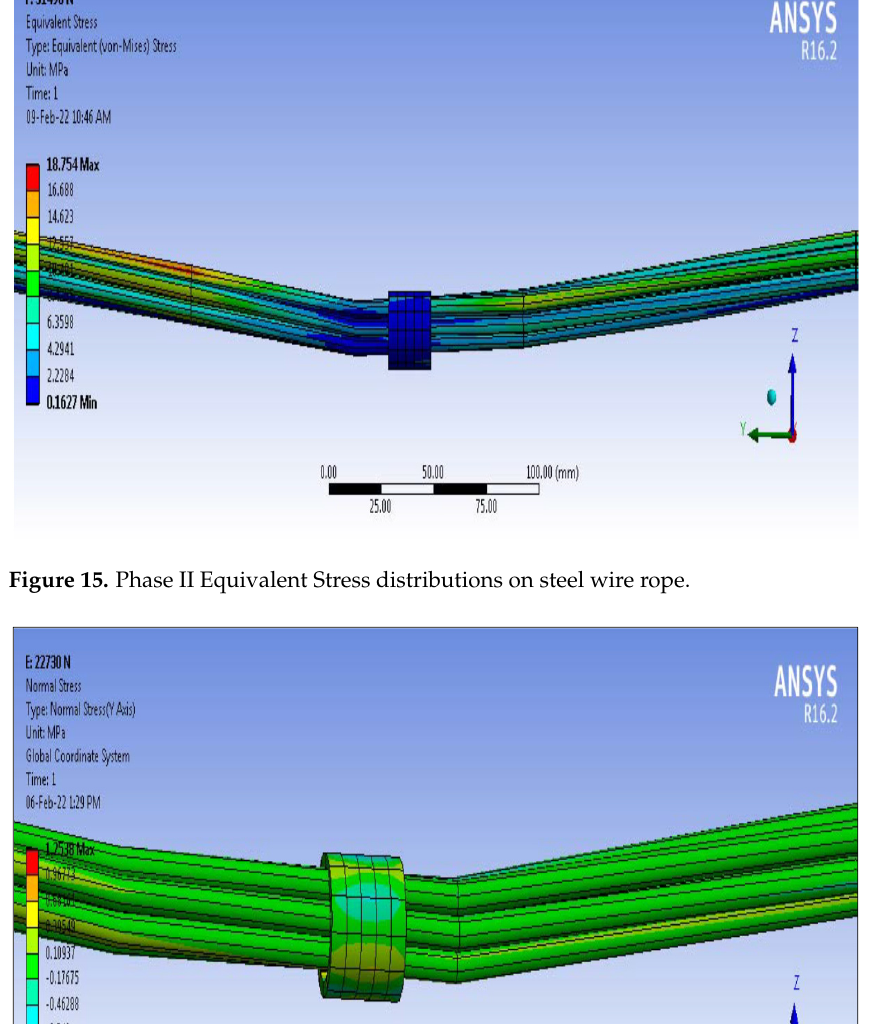
Figure 14. Phase I Normal Stress distributions on steel wire rope.